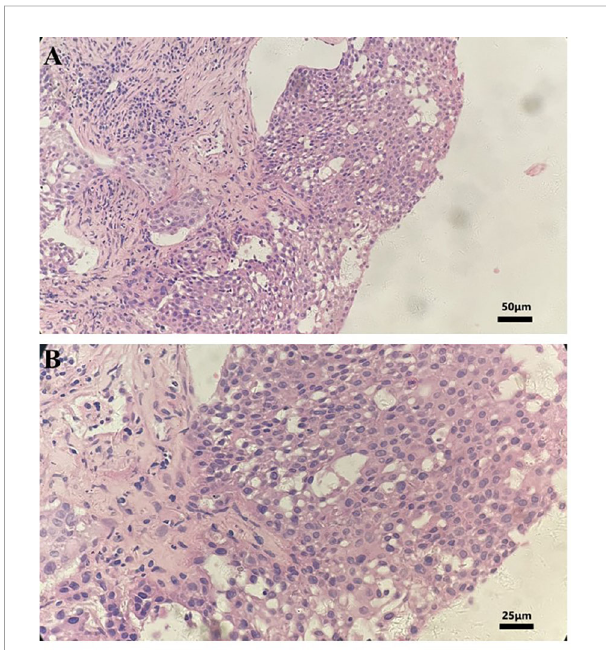
FIGURE 1 Hematoxylin and eosin staining photomicrographs of a right lung tumor tissue biopsy. (A) Magni fi cation, ×200. (B) Magni fi cation,